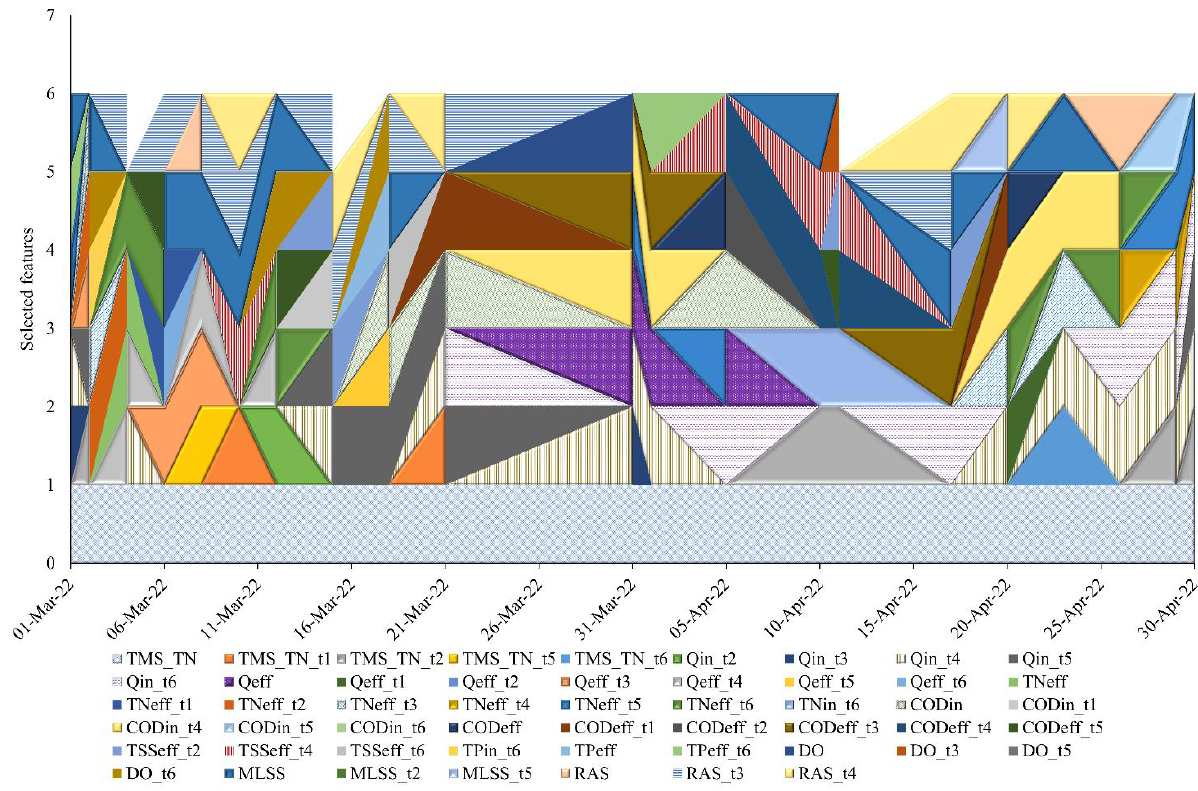
Figure 8. Selection of features using RFE in time series.